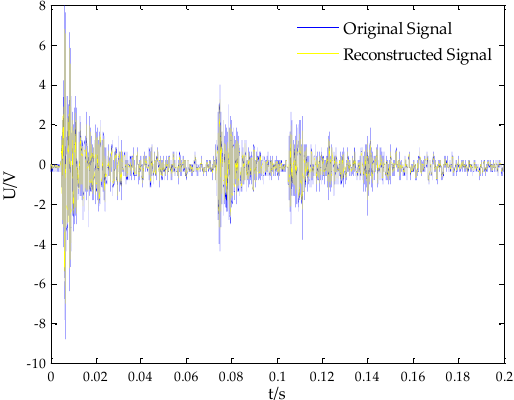
Figure 7. Comparison between the reconstructed signal and the original signal.